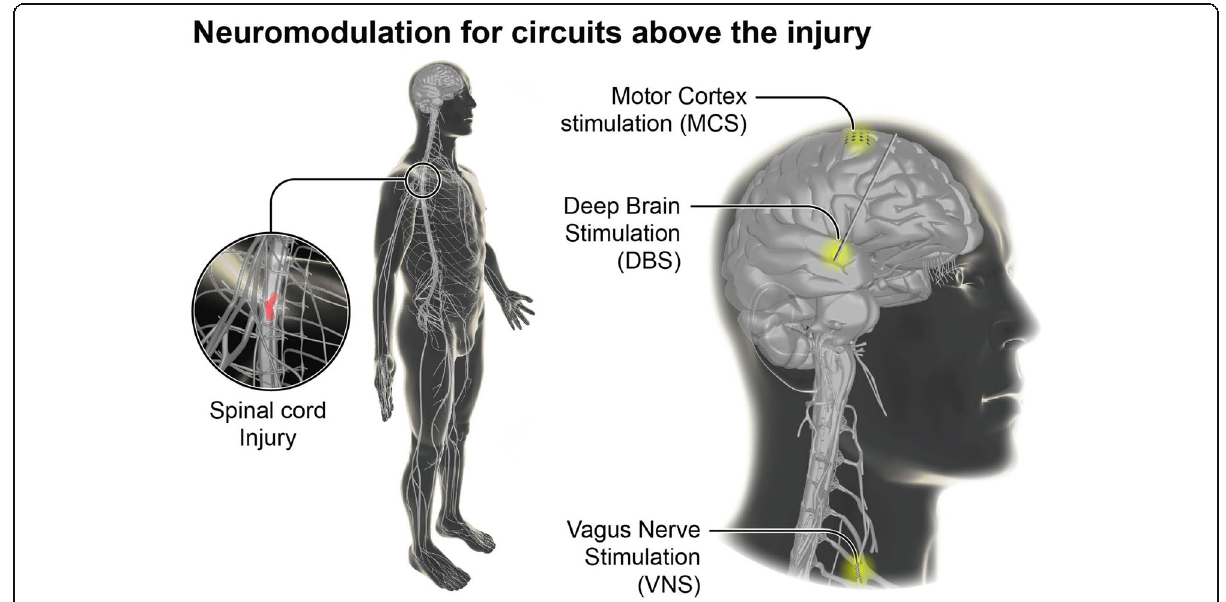
Fig. 2 Neuromodulation strategies to engage circuits above the lesion after SCI. Neuromodulation therapies have been delivered to the mesencephalic locomotor region (MLR) using deep brain stimulation (DBS) in order to facilitate locomotion. Motor cortex stimulation (MCS) has been applied for extensive periods of time daily to promote the growth and sprouting of corticospinal tract fibers. Finally, vagus nerve stimulation (VNS) has been applied to augment motor learning and plasticity during motor